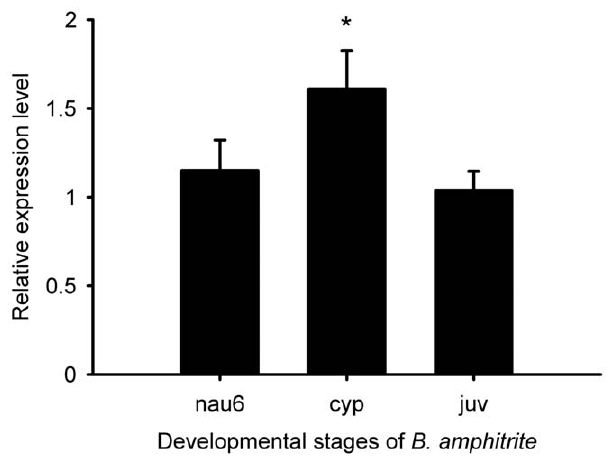
Figure 4. Ba-CaM mRNA expression levels in different develop- mental stages of B.amphitrite detected by real-time PCR. The stages included stage VI nauplius (nau6), cyprid (cyp) and juvenile (juv). Bars represent the mean 6 SD (n=3). An Asterisk (*) indicates a significant difference compared with the positive control ( P , 0.05).